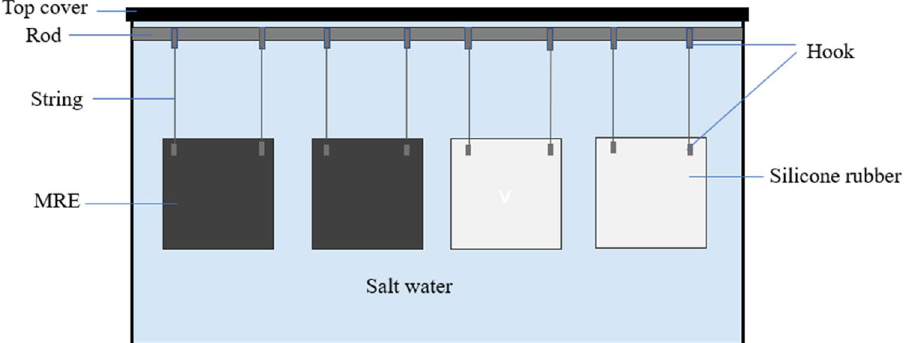
Figure 5. Arrangement of MRE and SR sheet in a salt water